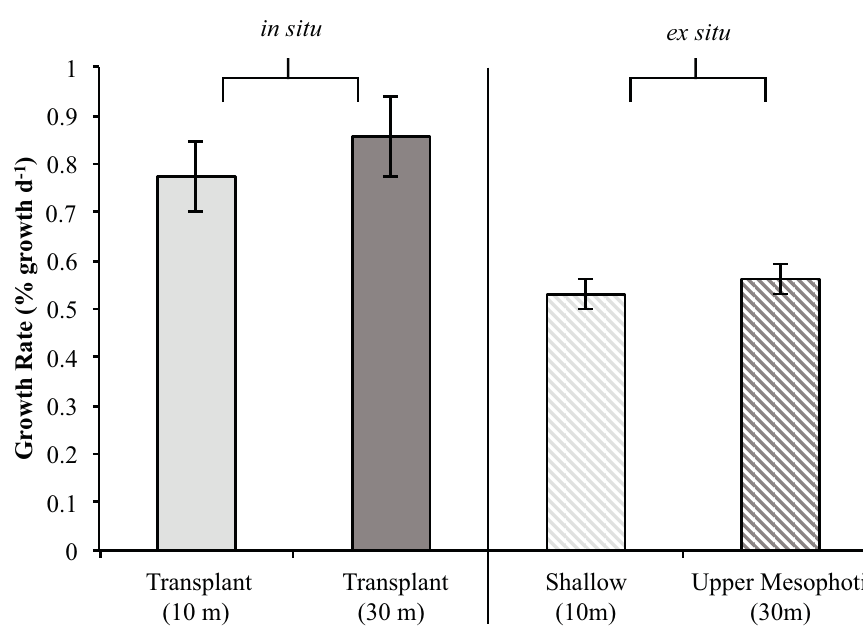
Fig 5. Specific growth of in situ and ex situ reared Porites astreoides . Specific growth of juvenile P . astreoides reared on shallow(10 m) and upper mesophotic(30 m) reefs ( in situ ) did not differ using transplant depth and Symbiodinium phylotypecombinations as factors (left). Specific growth of shallowand upper mesophoticjuvenile P . astreoides reared in outdoor aquaria( ex situ ) also did not differ (right). Both treatments of in situ reared juveniles (left) had significantly highergrowth rates than both treatments of ex situ reared juveniles(right). Shadedbars represent mean specific growth (% growth d -1 ) ±